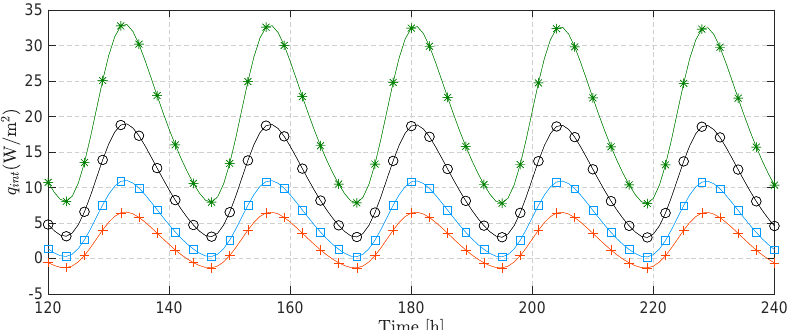
Figure 11. Heat flux distribution over time at the interior surface of the brick wall—shortwave extinction coefficient parameter, k s : ( ∗ ) 0.3; ( ◦ ) 0.5; ( (cid:3) ) 0.7; (+) 0.9.